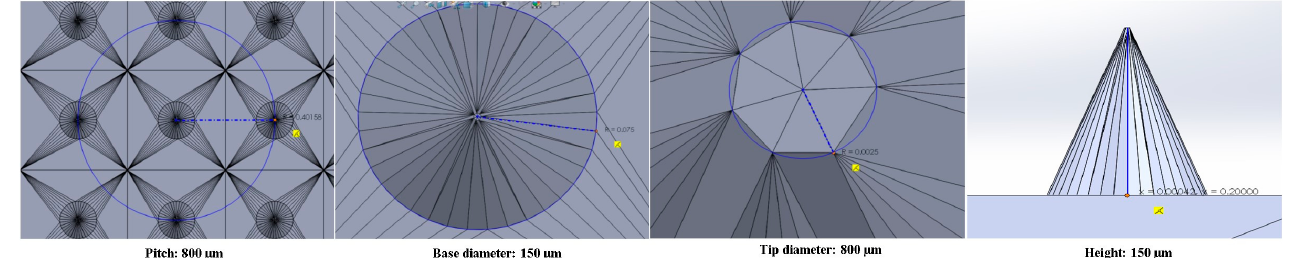
Figure 3. Projection micro-steriolithography (P µ SL) for 3D printed microneedles (CAD designs of targeted microneedle